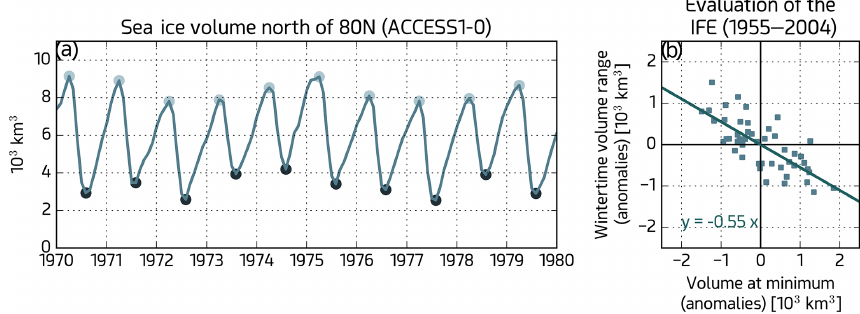
Figure 31. Quantitative evaluation of the ice formation efficiency (IFE). (a) Example time series (1970–1979) of the monthly mean Arctic sea ice volume north of 80 ◦ N of one CMIP5 model (ACCESS1-0), with its annual minimum and maximum values marked with the dark and light dots, respectively. (b) Estimation of the IFE, defined as the regression between anomalies of sea ice volume produced during the growing season (difference between one annual maximum and the preceding minimum) and anomalies of the preceding minimum. A value of IFE =− 1 means that the late-summer ice volume anomaly is fully recovered during the following winter (strong negative feedback damping all anomalies), while a value of IFE = 0 means that the wintertime volume production is essentially decoupled from the late-summer anoma- lies (inexistent feedback). Similar to extended data Fig. 7a–b of Massonnet et al. (2018a) and produced with recipe_seaice_feedback.yml ; see details in Sect. 3.3.4.